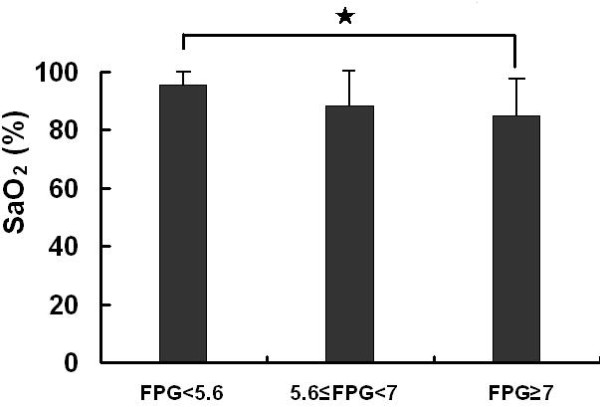
The comparison of SaO2 among different levels of FPG in H1N1 group *, p < 0.05.